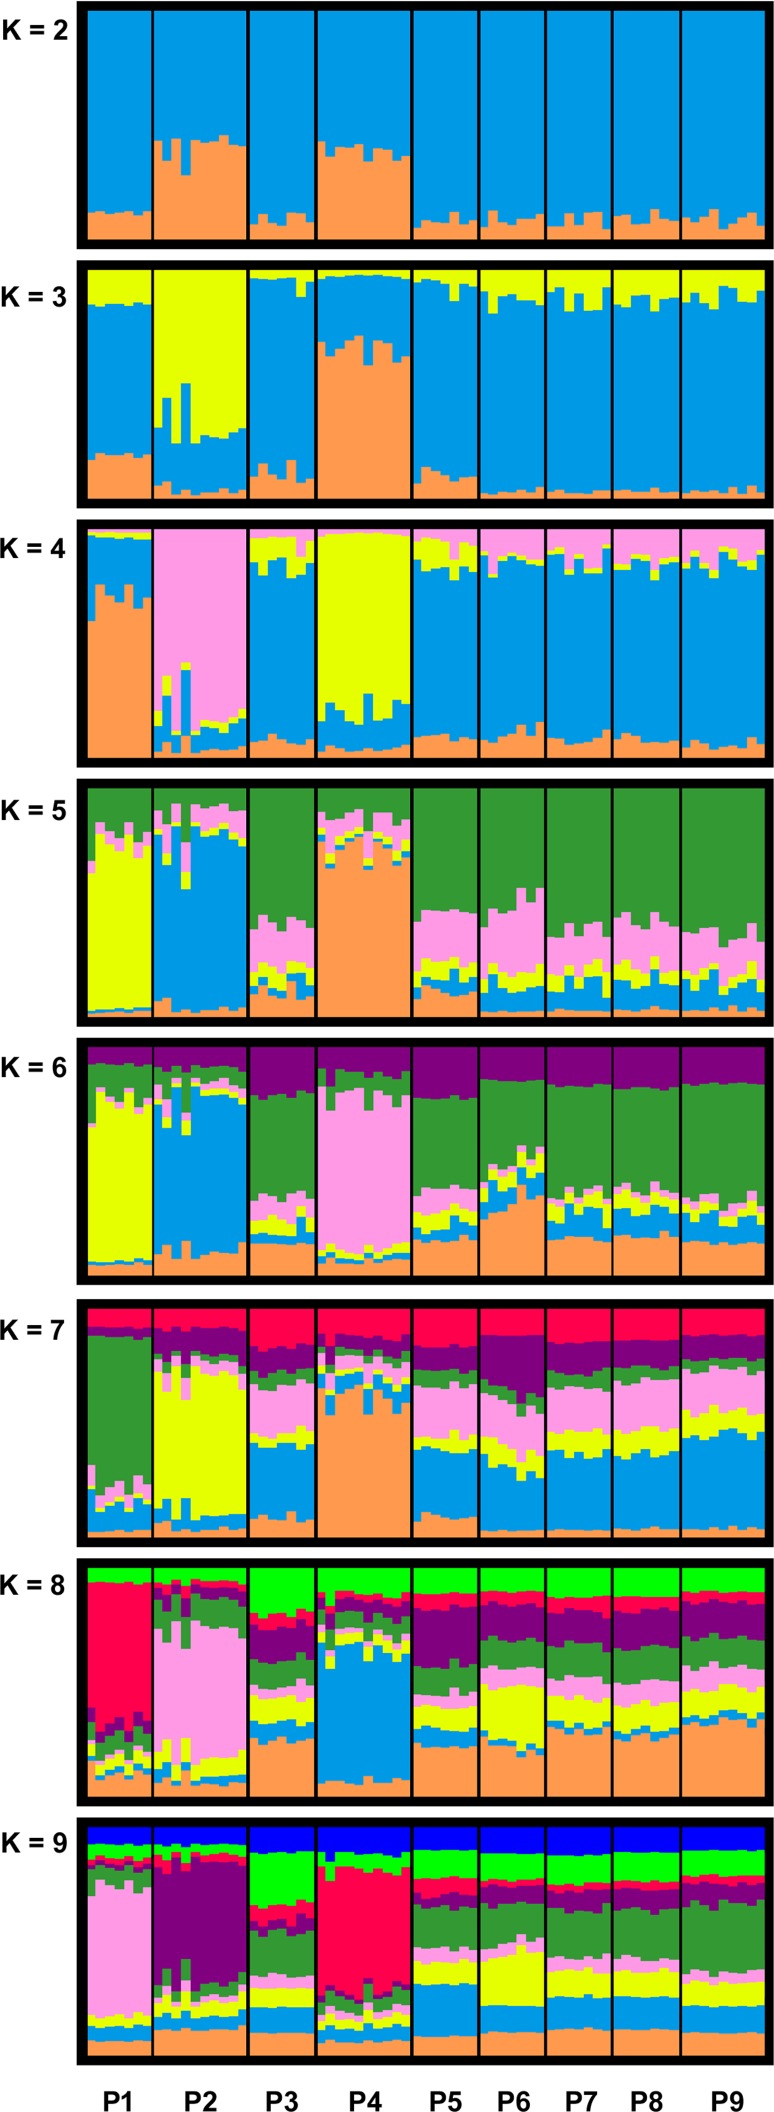
Bar plots of combined STRUCTURE analysis for clusters K = 2 to K = 9 of the investigated R. temporaria breeding pond populations in the study area.STRUCTURE HARVESTER identified K = 4 as the most meaningful number of clusters. Each vertical bar represents one individual, and the color composition visualizes the probability to belong to one of the K clusters defined by STRUCTURE. P10 was excluded from the analysis due to the different life stage of the samples.